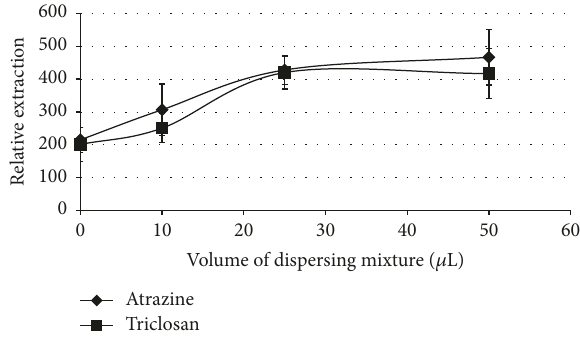
Figure 1: The effect of varying the volume of the extracting organic solvent on the extraction. Conditions: 1mL of 5 𝜇 g/mL triclosan and atrazine aqueous sample volume, varying volumes of a 1:4 (v/v) chlorobenzene :ethyl acetate mixture with the extraction time of 20 minutes and with toluene as the acceptor solvent. The relative extraction was calculated as a ratio of the peak areas of the analyte to that of the internal standard multiplied by